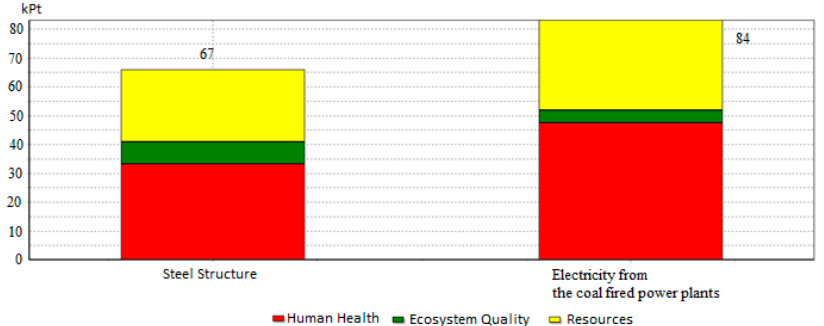
Figure 9. Weighted comparison of damage categories using Eco-Indicator 99